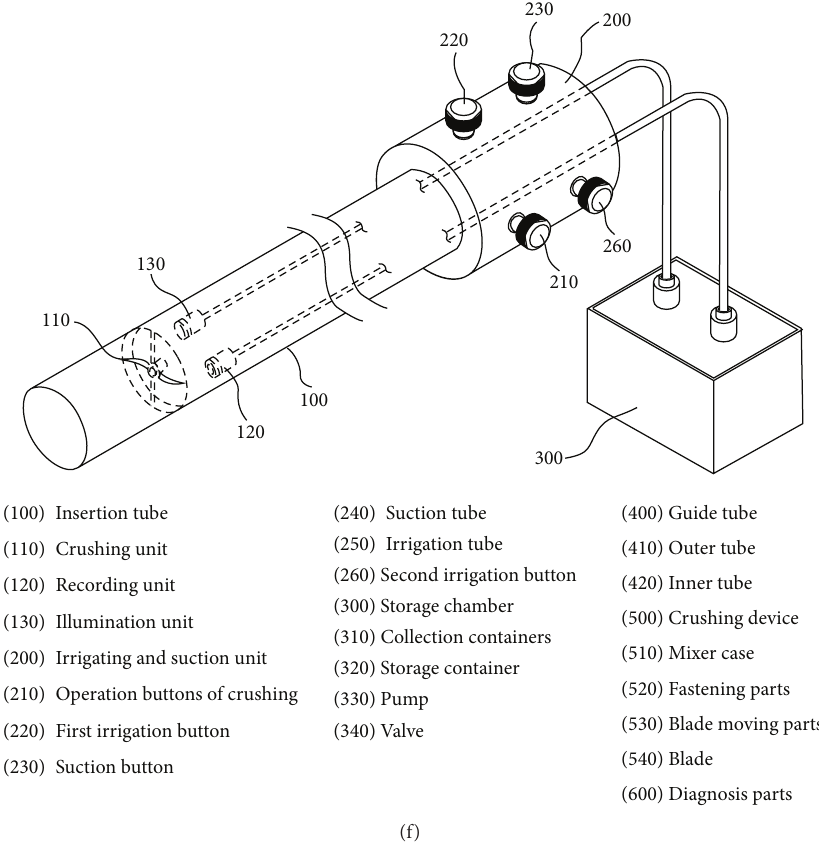
Figure 4: (a) Schematic control flow of the gastric content removing device; (b) endoscopic guide tube for evacuating gastric content; (c) irrigation and suction unit of the gastric contents; (d) mixer parts of crushing unit; (e) fastening parts of crushing unit; (f) appearance of the gastric content removing